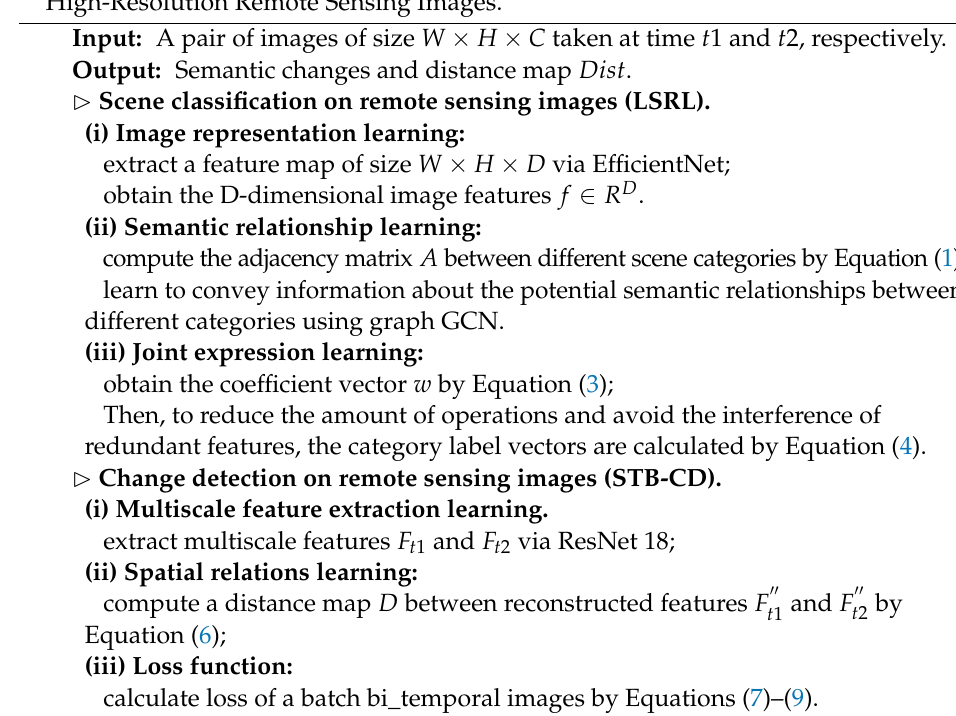
Algorithm 1: Scene Changes Understanding Framework based on Graph Con- volutional Networks and Swin Transformer Blocks for Monitoring LCLU using High-Resolution Remote Sensing